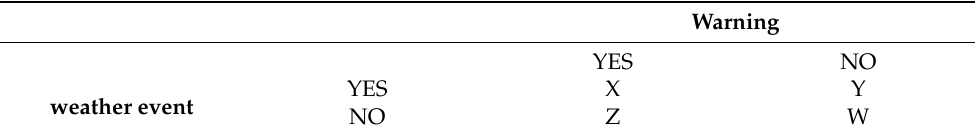
Table 2. 2 × 2 contingency table (X, Y, Z represent the number of times the model correctly warned, missed, falsely warned weather processes, respectively, and W represents the number of times the model correctly warned of no weather processes).